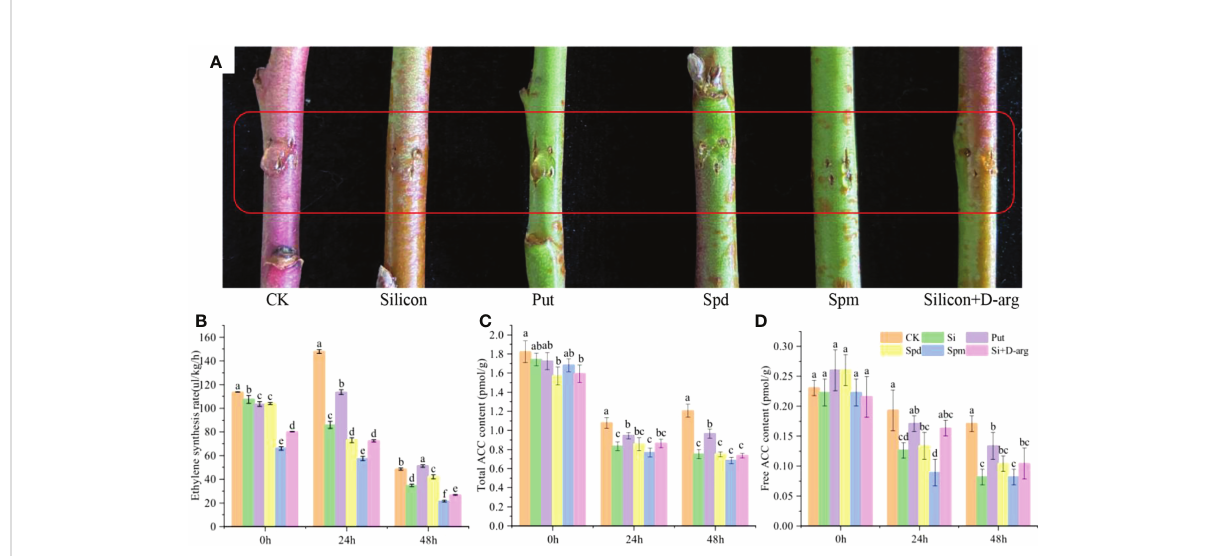
FIGURE 4 Spd and Spm inhibit ethylene synthesis in peach shoots. (A) Photograph of gum formation in peach shoots treated with water, Na 2 SiO 3 (0.6 mmol/L), Put (0.1 mmol/L), Spd (0.1 mmol/L), Spm (0.1 mmol/L) or Na 2 SiO 3 +D-Arg (10 mg/L) after 5 days. (B) Ethylene synthesis rates of differentially treated peach shoots. Total ACC content (C) and free ACC content (D) of peach shoots treated with different fl uids. Bars with different letters indicate signi fi cant differences (p < 0.05, Duncan ’ s multiple range